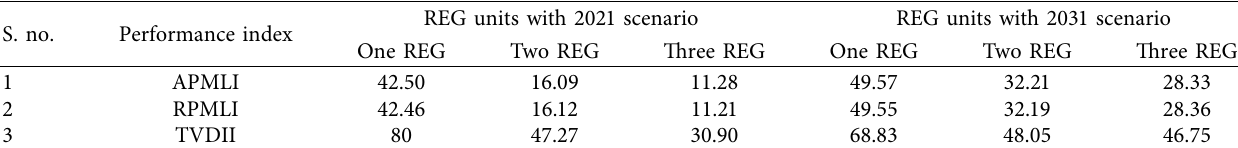
Figure 10: Voltage profle of network buses for the scenario of projected year 2031. Table 13: Performance